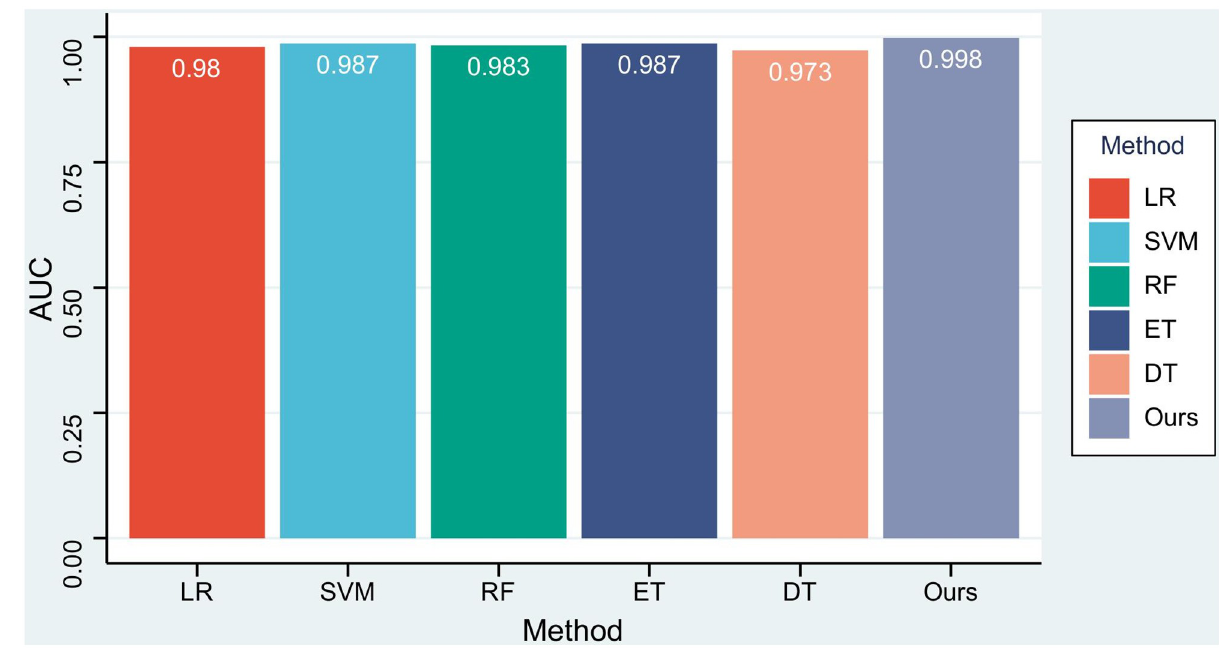
Fig 8. The AUCs of our method and machine learning